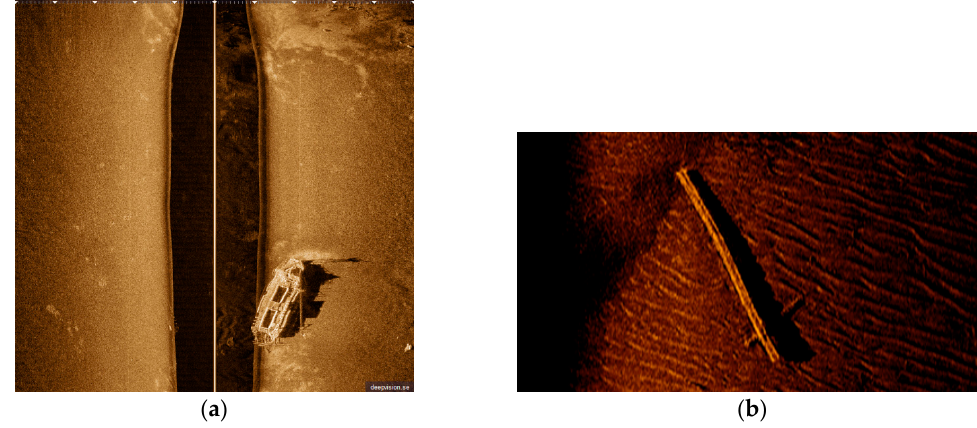
Figure 1. ( a ) High resolution SSS image recorded with the DE340D SSS at Stockholm sea [40]; ( b ) Low resolution SSS image generated by the 3500 Klein SSS (ECA Group company [41]).